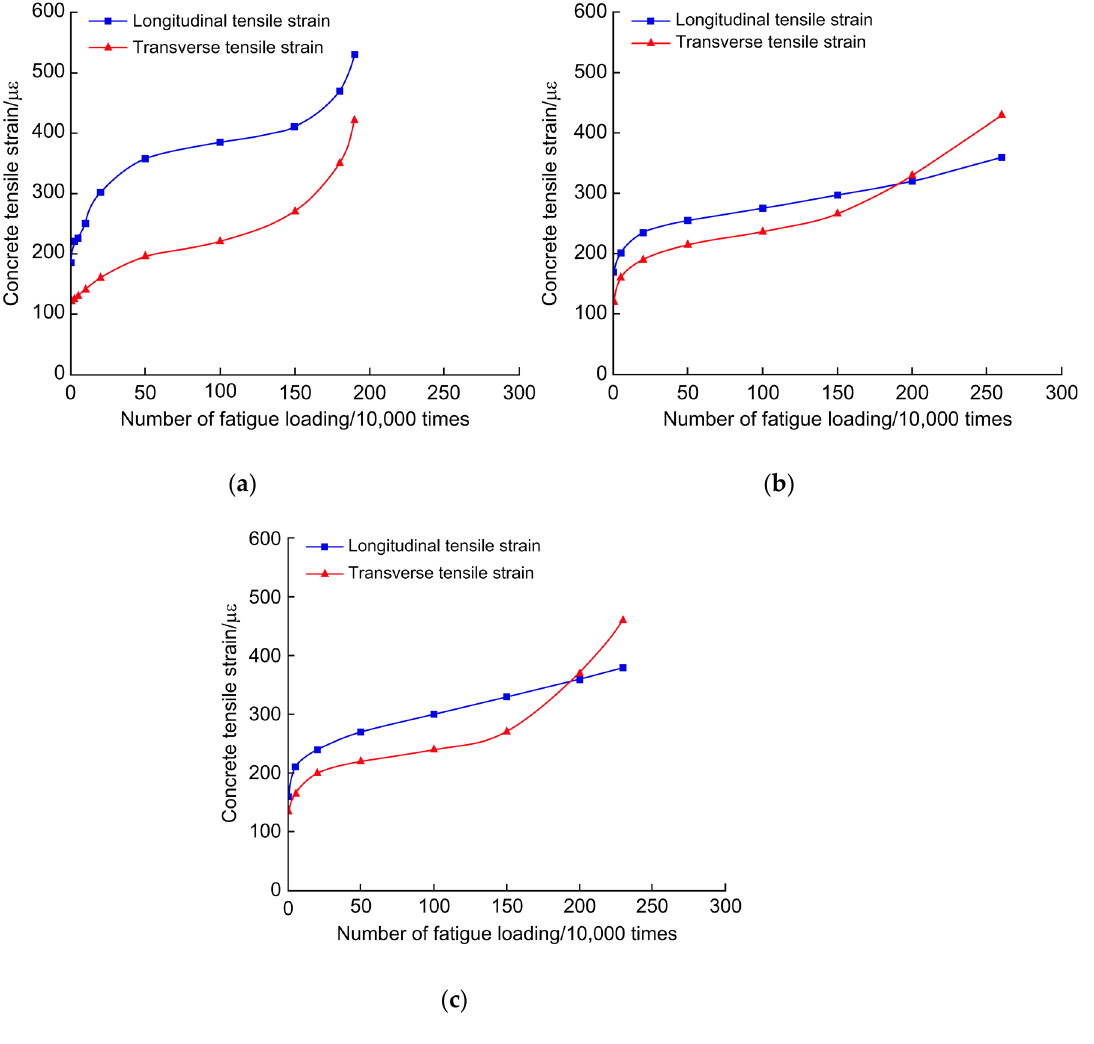
Figure 13. Change in concrete tensile strain under the slab based on number of fatigue loading cycles ( a ) PL2, ( b ) PL3, and ( c ) PL5.